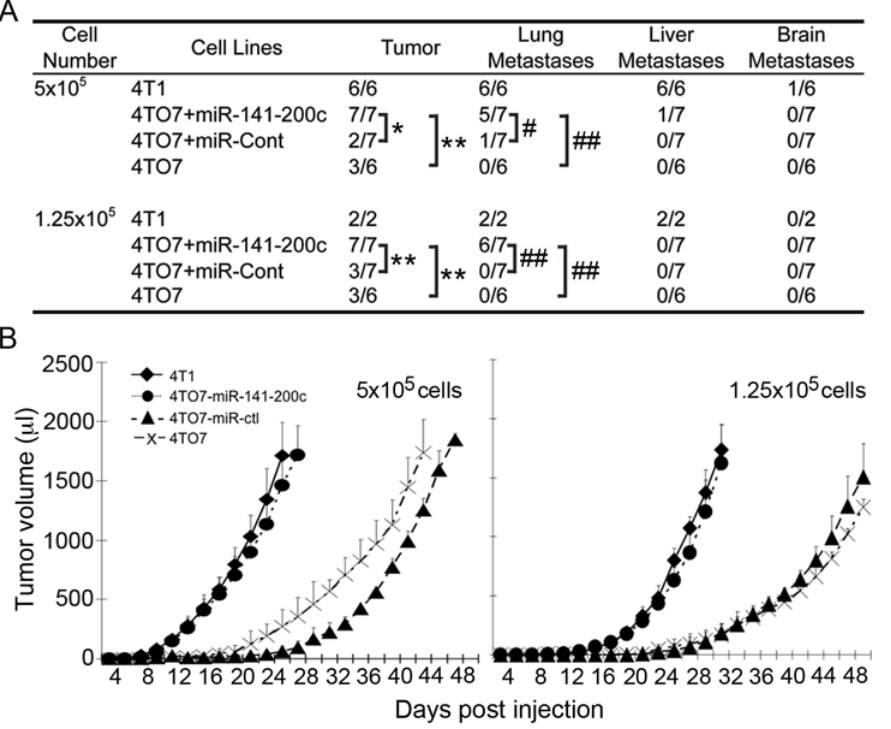
Figure 7. 4TO7 cells stably over-expressing miR-141-200c form tumors more rapidly that are more likely to metastasize. (A) Primary tumor and metastases is enhanced in 4TO7 cells stably over-expressing the miR-141-200c cluster. The indicated number of cells was injected in the mammary fat pad of female mice (*,p=0.02; **, p=0.07; # , p=0.1; ## , p=0.005). (B) Growth curves for primary tumors in mice injected with either 5 6 10 5 (left) or 1.25 6 10 5 cells